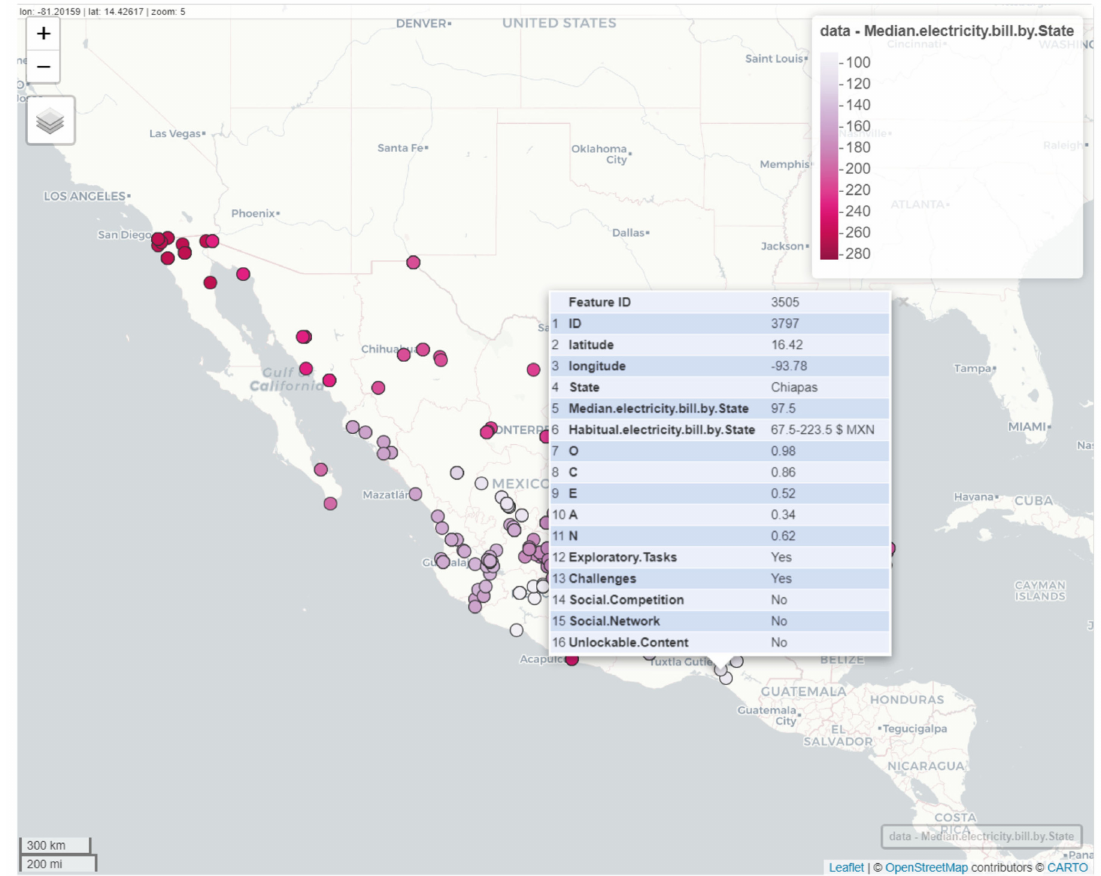
Figure 8. Map of Mexican personality traits and the electricity bill by state